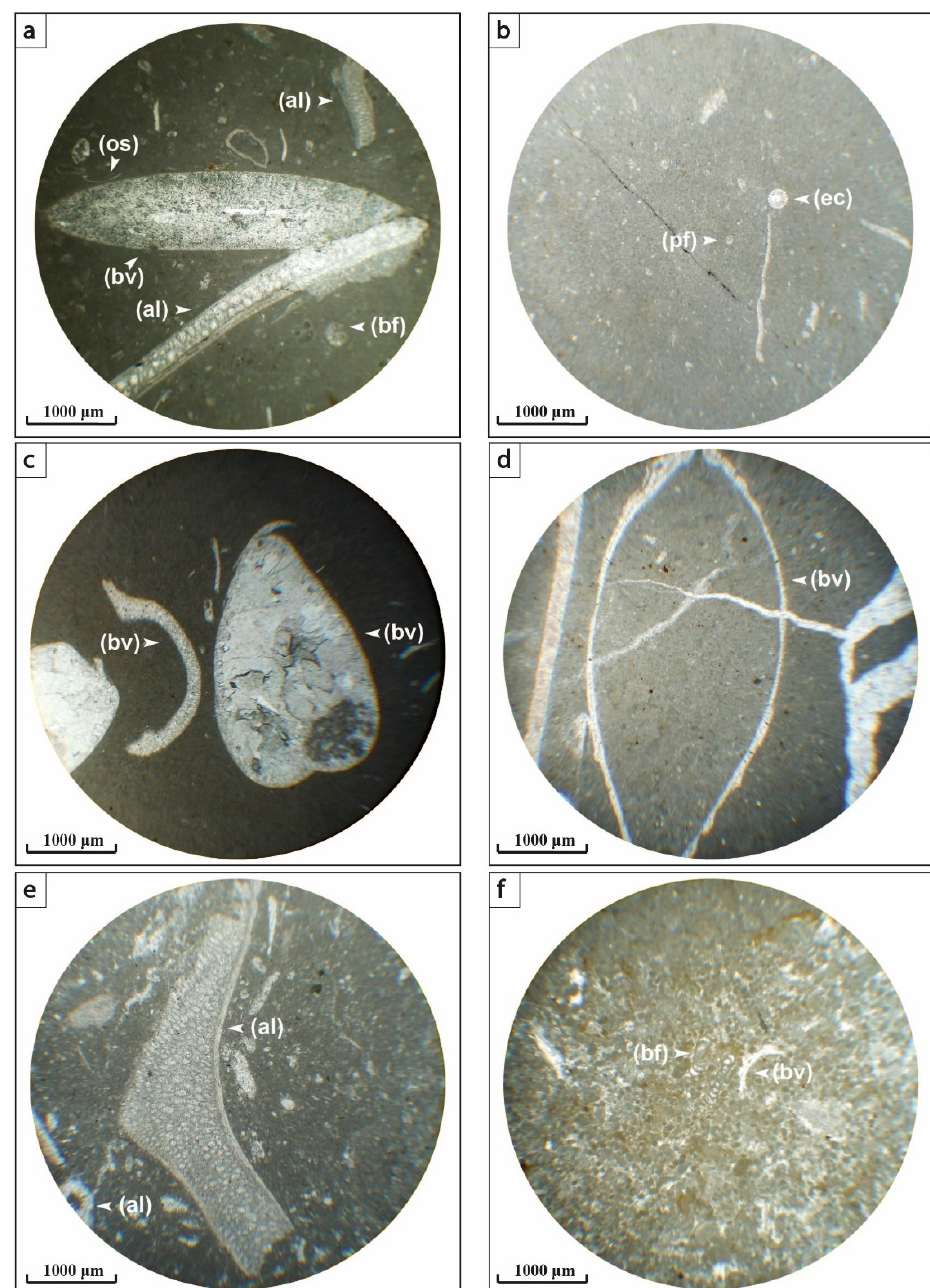
Figure 6. Thin section photographs of limestone microfacies of the Akrabou Formation in the Er-rachidia section. ( a ) bioclastic wackestone containing bivalves (bv), algae (al), ostracods (os), and benthic foraminifera (bf); ( b ) mudstone with echinoids (ec); ( c ) wackestone containing recrystallized bivalve shells (bv); ( d ) wackestone with bivalve shells (bv); ( e ) wackestone containing broken algal fragments (phylloid algae); ( f ) peloidal wackestone containing bivalve shells (bv) and benthic foraminifera (bf, milioilidae).